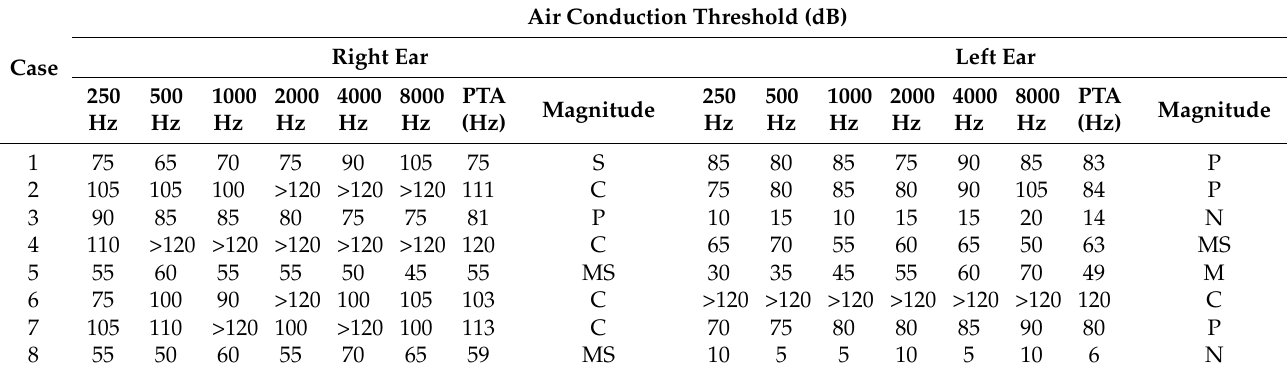
Table 2. The characteristic of pure tone audiometry in eight patients with